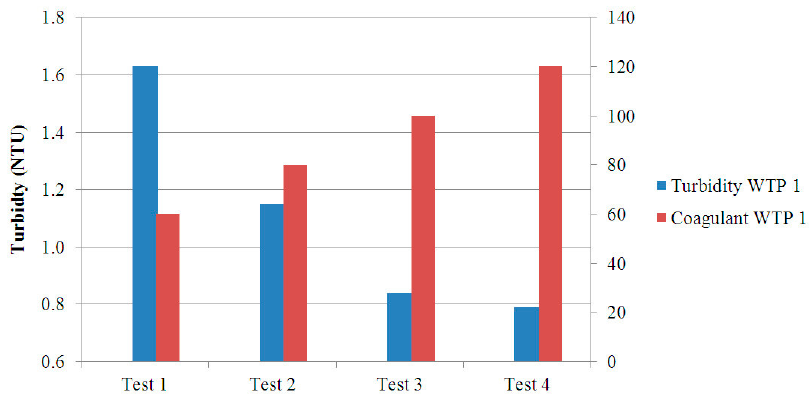
Figure 13. Turbidity and coagulant dosage values for each vessel in the JT of the WTP 1.